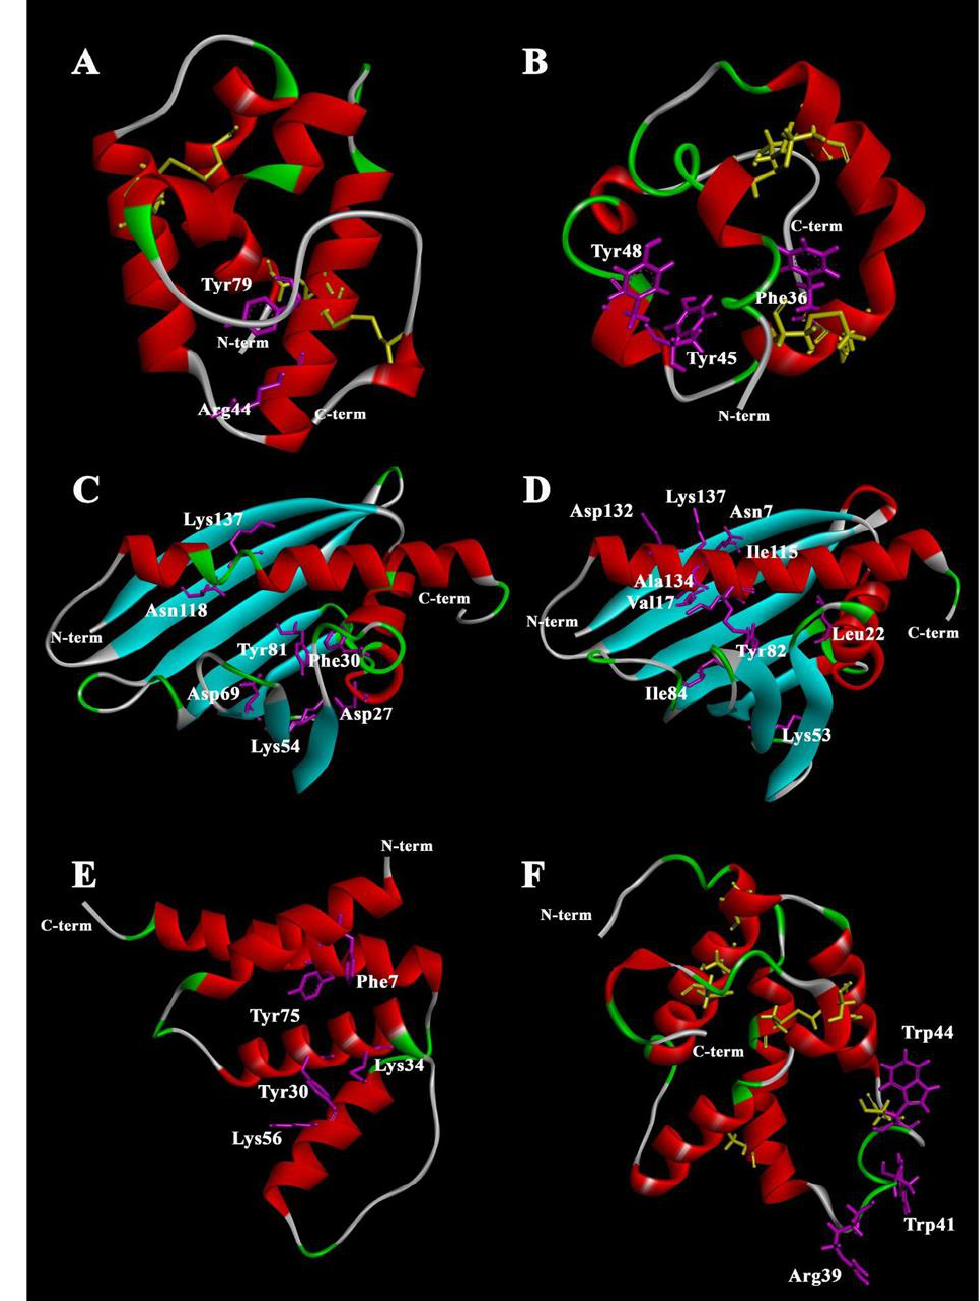
Figure 1. Spatial structures of plant lipid-binding proteins. ( A ) Rice LTP1 [PDB: 1RZL]; ( B ) rice LTP2 [PDB: 1L6H]; ( C ) birch Bet v 1 [PDB: 4A88]; ( D ) yellow lupin LlPR-10.1A [PDB: 4RYV]; ( E ) rice acyl- coa-binding protein 2 [PDB: 5H3I]; ( F ) PIN structure prediction using iterative threading assembly refinement I-TASSER. Key amino acid residues participating in ligand binding are highlighted in magenta. Cysteines and cysteine bridges are highlighted in yellow. The structures were visualized in Discovery Studio Visualizer (Dassault Systèmes BIOVIA, Discovery Studio Visualizer, v20.1.0.19295, San Diego: Dassault Systèmes, 2020).